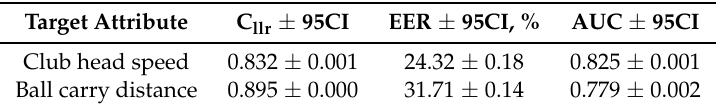
Table 3. Decision-level fusion for detection task: summary of results. Note: 95CI stands for 95% confidence interval (mean and corresponding 95% CI are obtained after repeating the task 100 times).